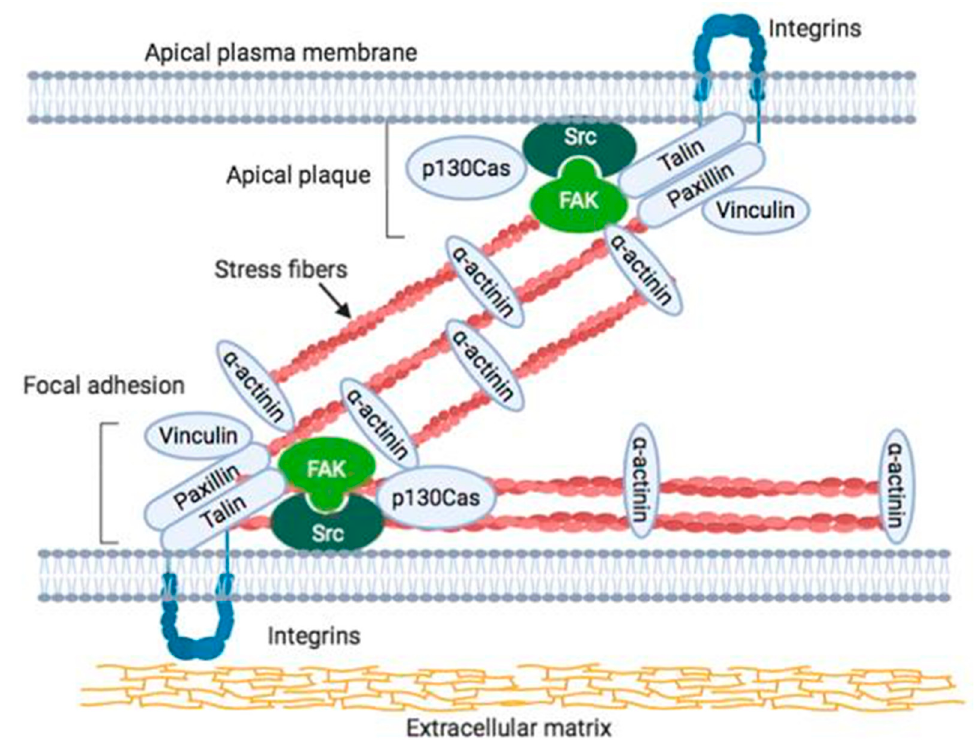
Figure 1. Schematic illustration of apical plaque and focal adhesion. Extracellular matrix, integrin, and cytoskeletal proteins, such as talin, paxillin, and vinculin, are localized in both the apical plaque and the focal adhesions. FAK–Src complex is also localized in both the apical plaque and the focal adhesions at the basal portion of the cell, which indicates that the complex acts as signal transduction machinery. Localization of FAK in apical plaque is very few or not detected [60].